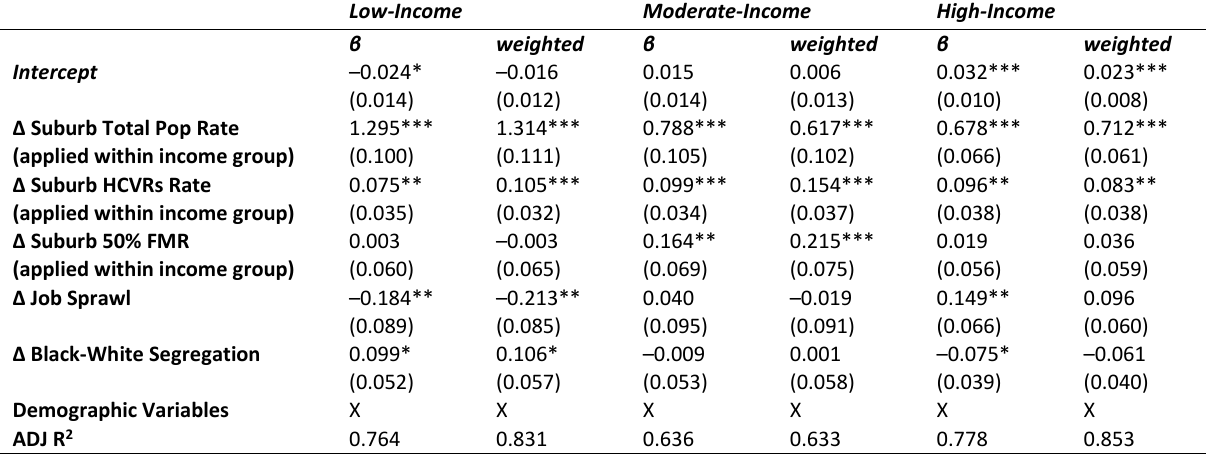
Table 4. 1st difference multivariate regression of suburban share poor (by income of suburb), 2000–2008 (N =